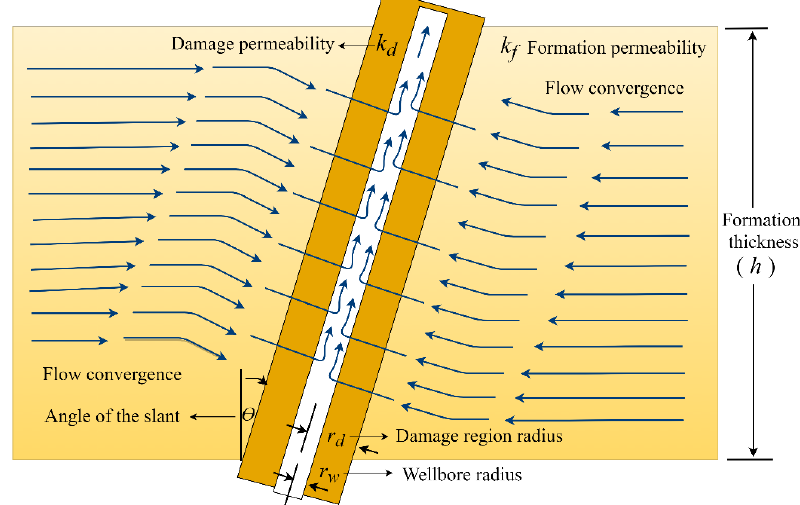
Figure 1. Schematic of inclined open-hole well flow with formation damage.